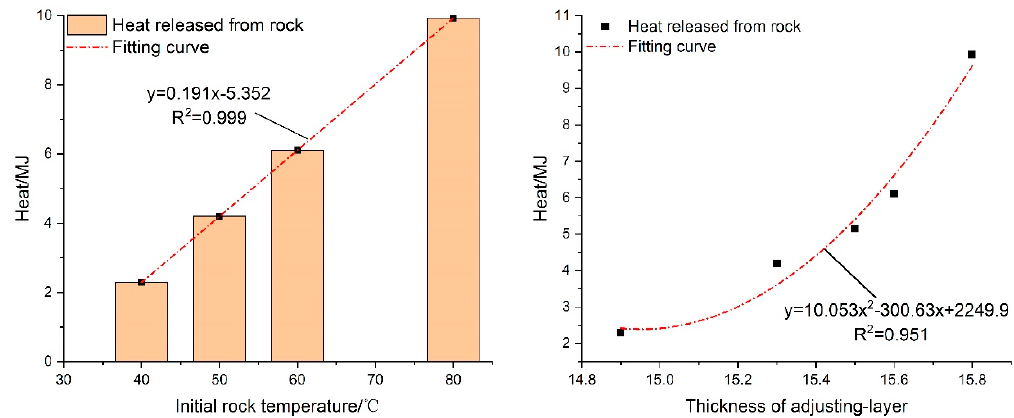
Figure 14. The quantity of released heat from radial surrounding rock. (Left) . Rock temperature vs released heat (Right) Thickness of adjusting-layer vs released